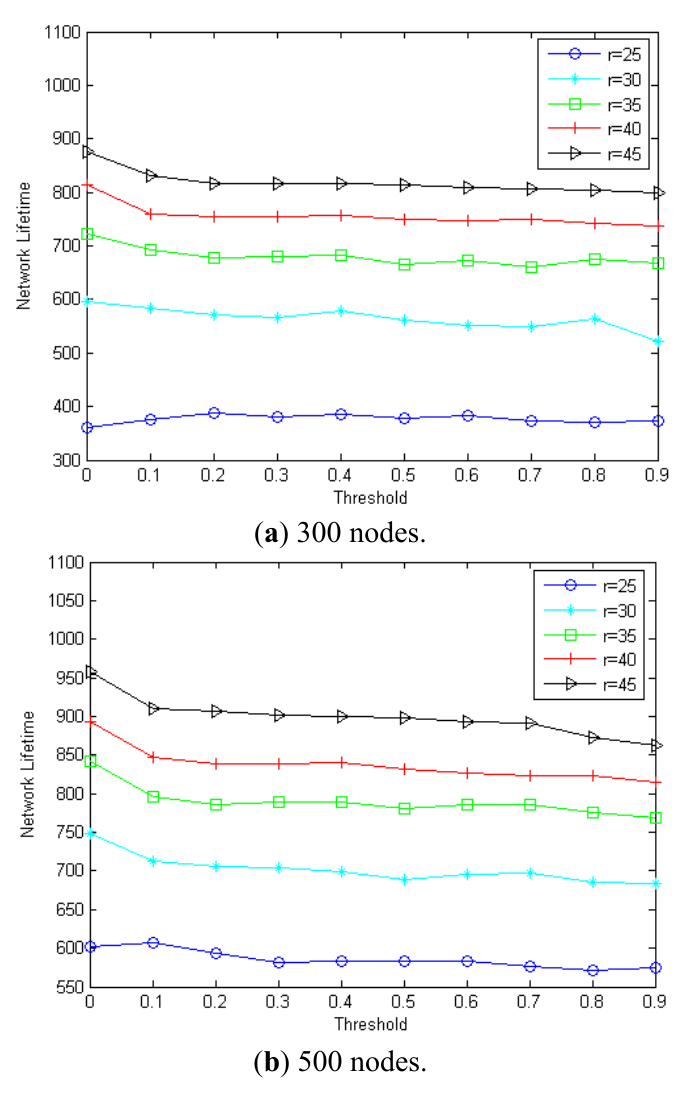
Figure 13. The impact of threshold on the performance of MEBS. ( a ) 300 nodes; ( b ) 500 nodes.